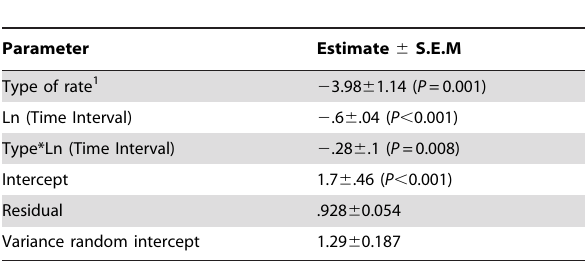
Table 4. Estimates of fixed effects and covariance parameters for the linear mixed model of interaction between rate, type of rate (biological or cultural rates), and time interval.